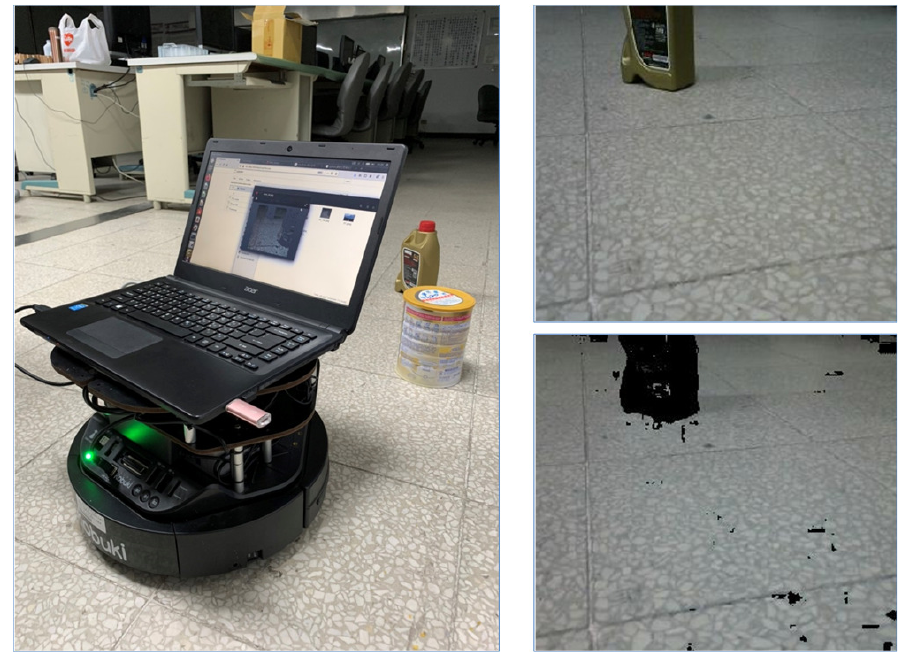
Figure 8. Proposed algorithm deploying to a ROS compatible TurtleBot-II UGV rover-style